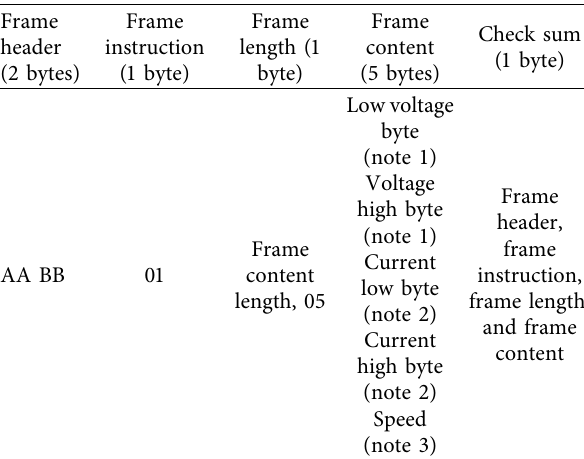
Figure 6: Diagnostic Table 1: Data frame composition.